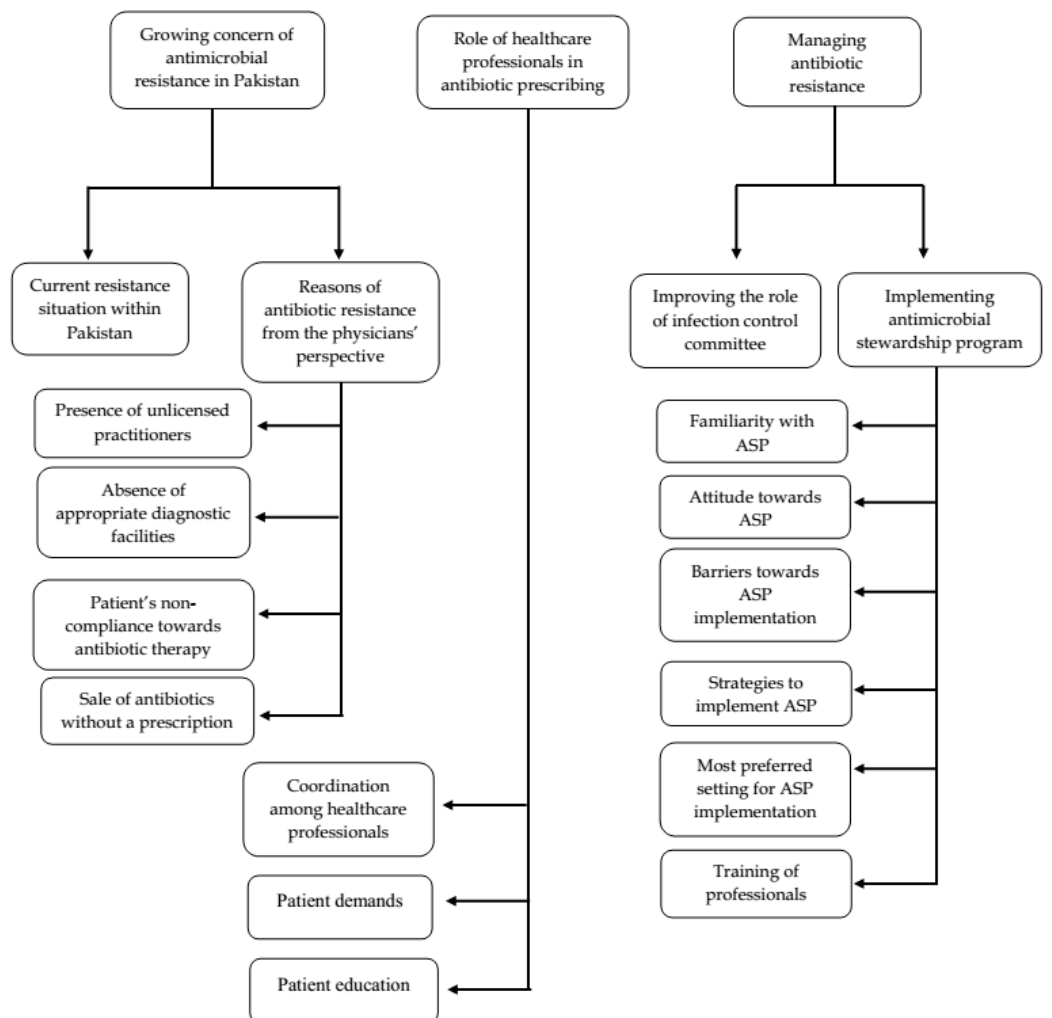
Figure 2. Summary of emerged themes and sub-themes.